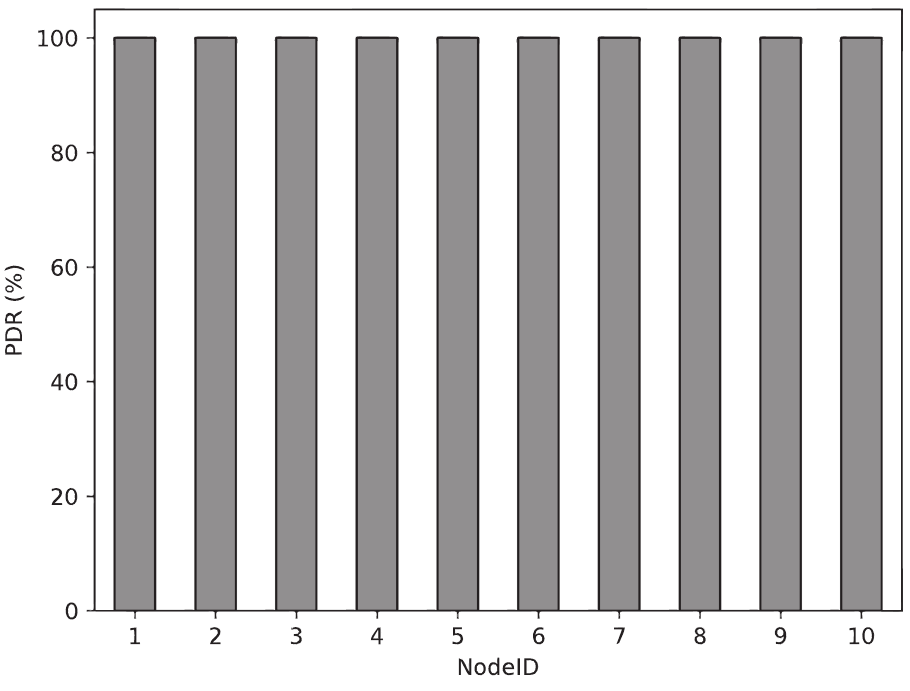
Figure 10. PDR of IEEE 802.15.4 in scenario